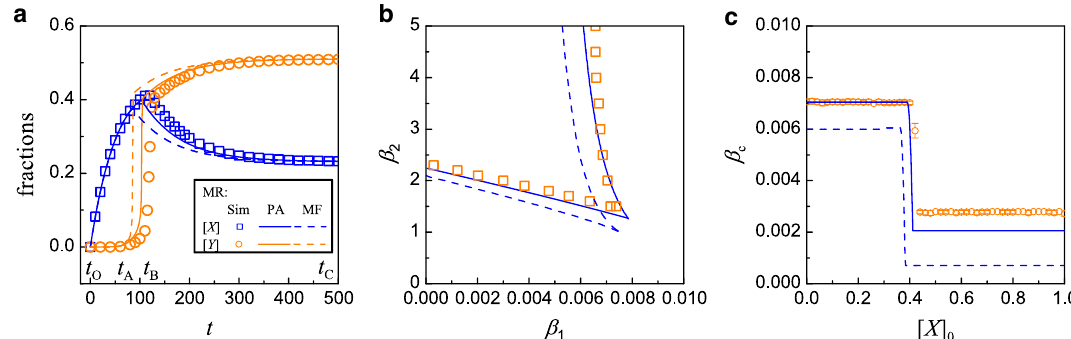
Fig. 4 Comparison of simulation results with predictions from PA analysis and mean- fi eld theory for the MR model. a Time evolution of the fraction of inactive nodes. The initial conditions are [ X ] 0 = [ Y ] 0 = 0. The parameter values are β 1 = 0.009, β 2 = 2.0, μ 1 = 0.01, and μ 2 = 1.0. Several time instants are marked to facilitate visualization of the time evolution in different stages: t O = 0, t A = 60, t B = 120.7, and t C = 480. b Phase diagram on the ( β 2 − β 1 ) parameter plane. Other parameters are μ 1 = 0.01, and μ 2 = 1.0. c Dependence of β c on the initial value of [ X ] 0 , with [ Y ] 0 = 0. The solid (dashed) curve is calculated by the PA (mean- fi eld) theory, and the symbols are for simulation results obtained by averaging over